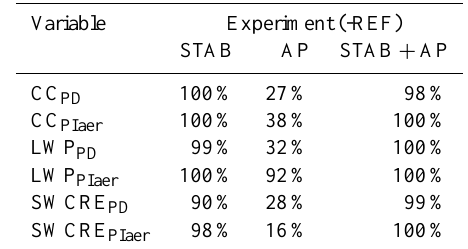
Table B2. Same as Table B1 but the t test is applied to annual mean values of (AMIP) simulations of an experiment and the refer- ence experiment. CC stands for cloud cover, SWCRE for shortwave cloud radiative effect, subscript PD for present-day aerosol emis- sions and PIaer for preindustrial aerosol emissions. Variable Experiment